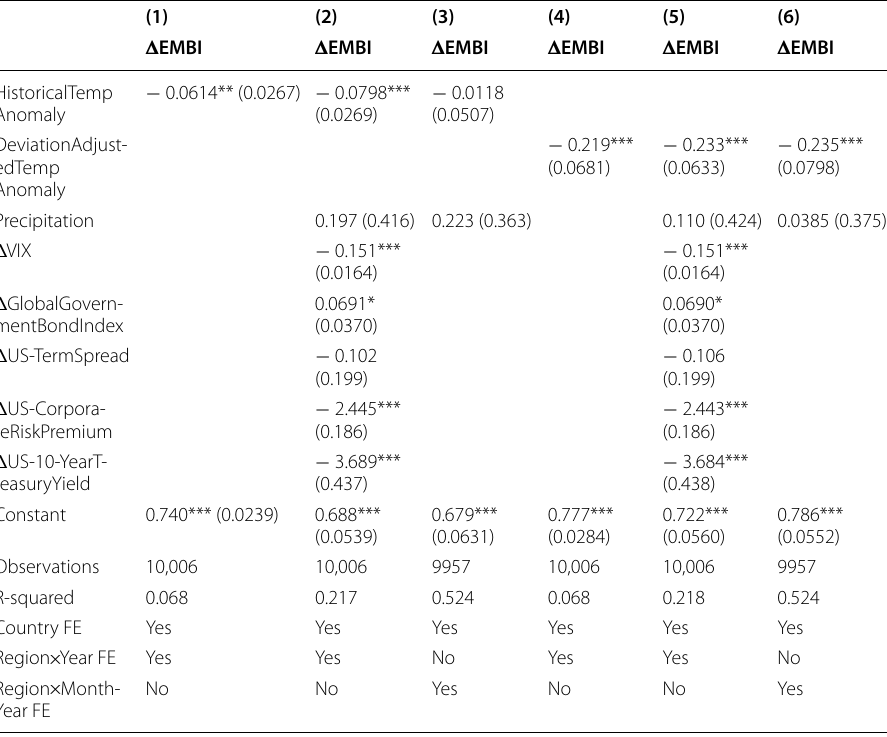
This table shows OLS estimation results of a panel of 54 countries from 1994m1 to 2018m12. (cid:31) EMBI are monthly natural log returns of a country’s EMBI index. HistoricalTempAnomaly is the difference between monthly temperature of a country and its 1901–1950 temperature average of the same month. DeviationAdjustedTempAnomaly is the anomaly measure divided by a country’s 1901–1950 average of temperature standard deviation. Precipitation is the country-specific average in 1000 mm units. (cid:31) VIX, (cid:31) US-TermSpread (10-year treasury yield minus 3-month T-Bill yield), (cid:31) US-CorporateRiskPremium (high corporate bond yield minus investment grade corporate bond yield) and (cid:31) US-10-YearTreasuryYield are in simple first differences, (cid:31) GlobalGovernmentBondIndex is in natural log differences. Standard errors (in parentheses) are clustered at the country level and control for heteroscedasticity and serial correlation, ***, ** and * indicate statistical significance at the 1%, 5% and 10% level, respectively. See Table 18 for variable definitions and